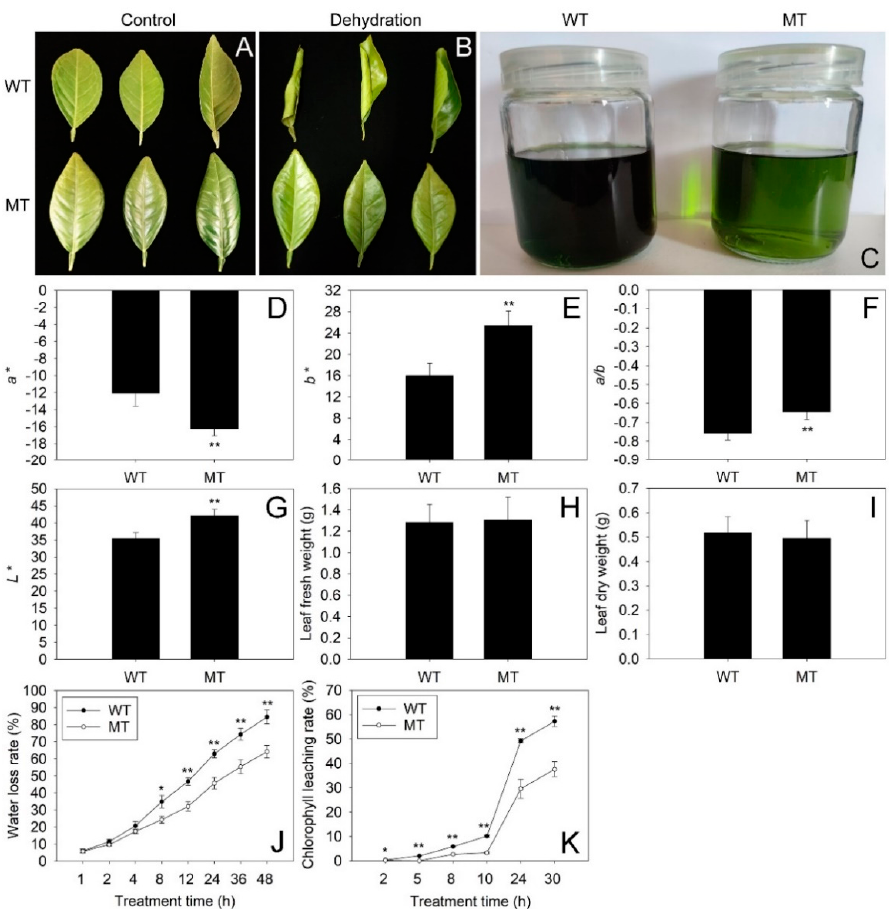
Figure 1. Analyses of phenotype, chromatic aberration and cuticular permeability in WT and MT leaves. ( A , B ) The phenotype of WT and MT leaves under control (well − watered) and dehydration stress (leaves detached and placed in dark condition for 48 h). ( C ) The chlorophyll leaching conditions of WT and MT leaves immersed in an alcohol solution for 30 h. ( D – G ) The values of a *, b *, a */ b * and L * detected by a colorimeter. Vertical bars represent standard deviations of the means ( n = 15). ( H , I ) The fresh and dry weight in WT and MT leaves. ( J , K ) The comparison of water loss rates and chlorophyll leaching rates in WT and MT leaves. Vertical bars represent standard deviations of the means ( n = 3). Significant differences between WT and MT leaves at the p < 0.05 and p < 0.01 levels were indicated by * and **, respectively, according to Student’s t